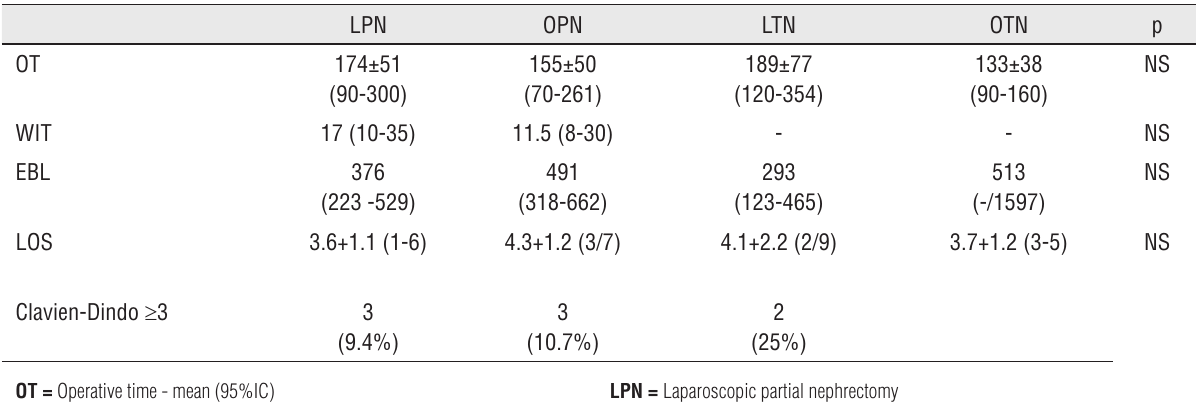
Table 4 - Perioperative outcomes and surgical